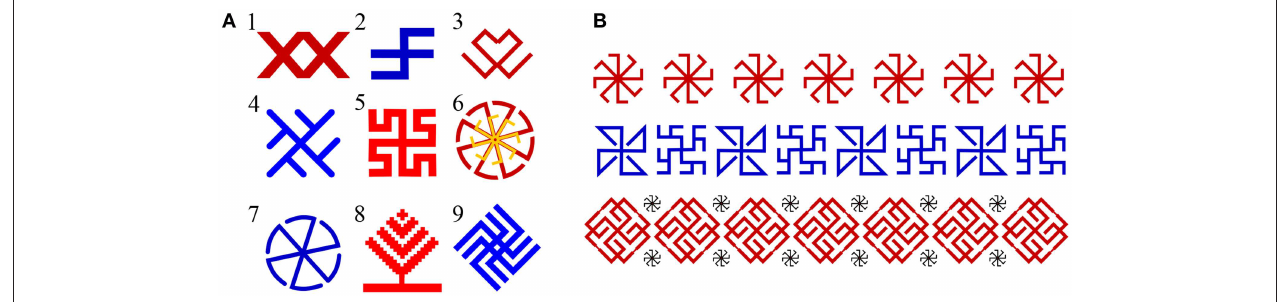
FIGURE 1 | (A) Some symbols in geometric Slavic ornaments and their Slavic names (with English translations, if possible): 1—“ vodyanoj ” ( the water sprite ); 2—“ slavez ”; 3—“ kryuchki ” ( hooks ); 4—“ kolard ”; 5—“ bogovnik ”; 6—“ svetoch ” ( cresset ); 7—“ grozovik ” ( the spirit of thunderstorm ); 8—“ derevo ” ( tree ); 9—“ vepr’ nebesnyj ” ( the sky wild boar ). (B) Top: a row of the symbols “ kolyadnik ” ( a kind of Christmas carol ); middle: alternations of the symbols “ solon’ ” and “ the fern flower ”; bottom: rows of the symbols “ skarozhych ” and “ kolyadnik